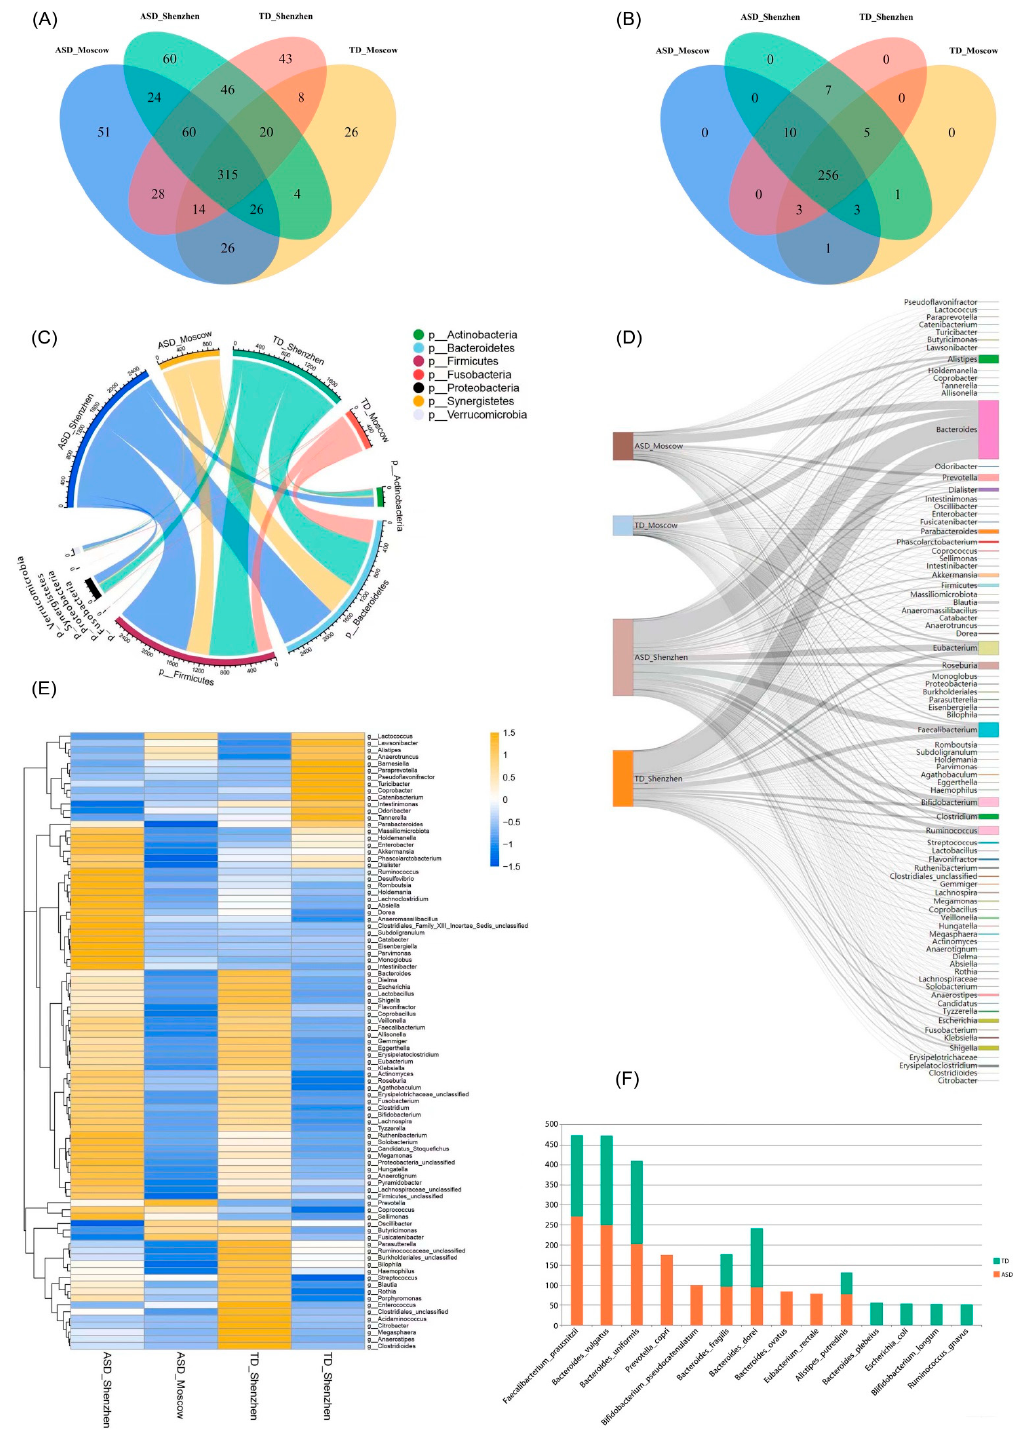
Figure 3. Microbiome profiles of ASD and TD groups. ( A ) There were a total of 749 species in the gut microbiota for our analysis. ( B ) After the data reduction to exclude those species with noise and less information, 285 species remained. ( C ) The most abundant phyla in ASD and TD groups. ( D ) The top ten abundant genera in both ASD and TD groups. ( E ) The hierarchical heatmap indicated the more abundant genus in the TD group and the more abundant genus in the ASD group. ( F ) Species composition of ASD and TD groups ranked among the top ten in relative abundance at the species